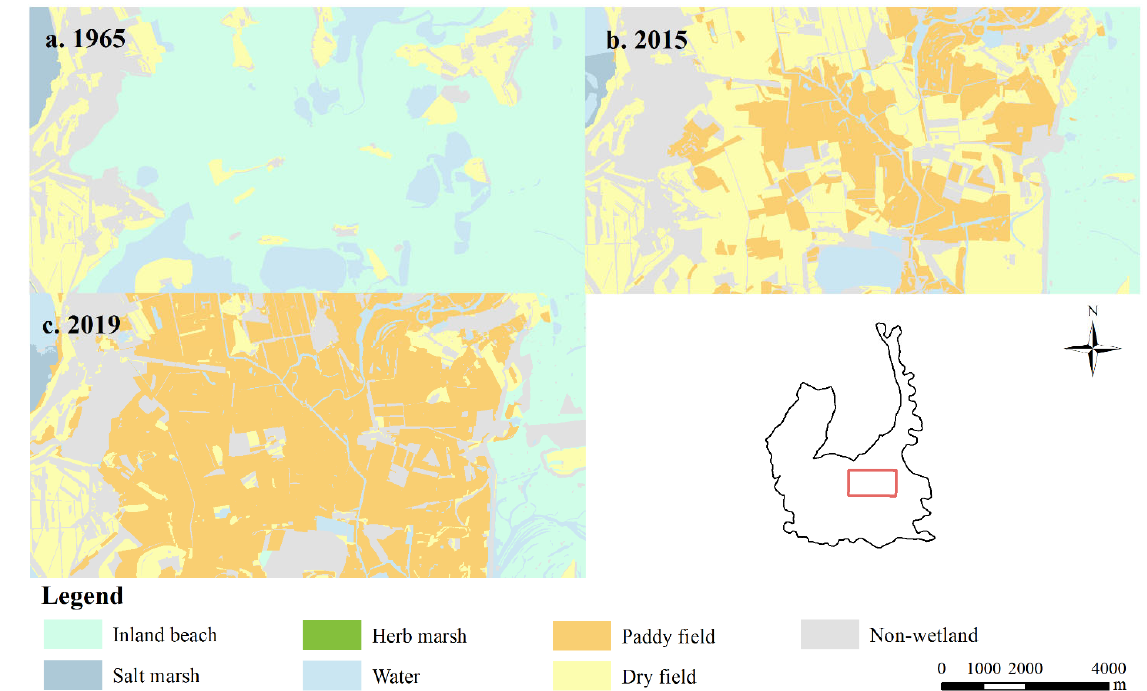
Land 2022 , 11 , x FOR PEER REVIEW Figure 5. Maps of typical water area changes from 1965 to 2019. Figure 5. Maps of typical water area changes from 1965 to 2019.